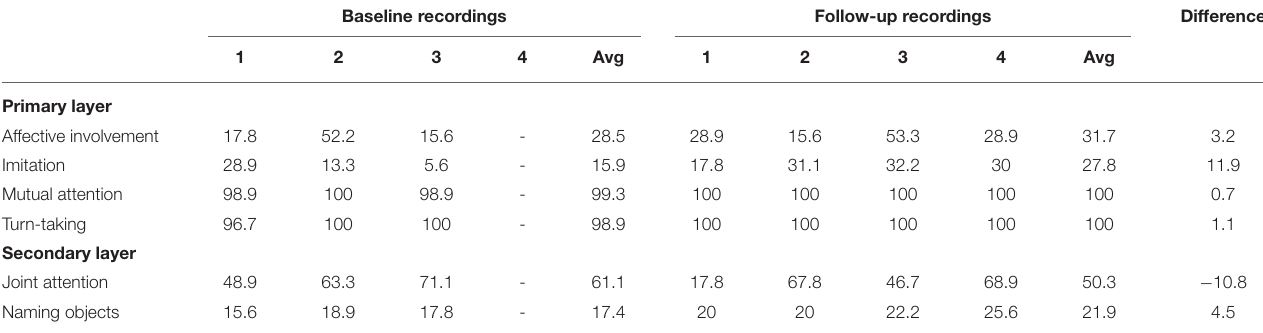
TABLE 4 | Percentage presence of LCM behaviors and difference in presence between baseline and follow-up recordings for dyad 2. Baseline recordings Follow-up